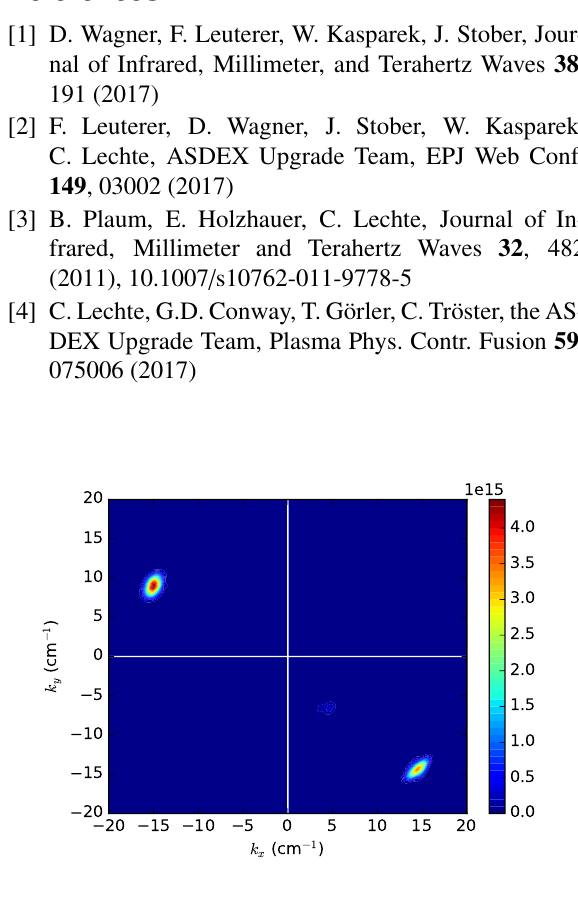
Figure 8. Power spectrum of the plane wave decomposition of incident (upper left) out reflected (lower right) wave. A spurious di ff raction order is just visible at k = (4 . 6 , − 6 . 6)cm − 1